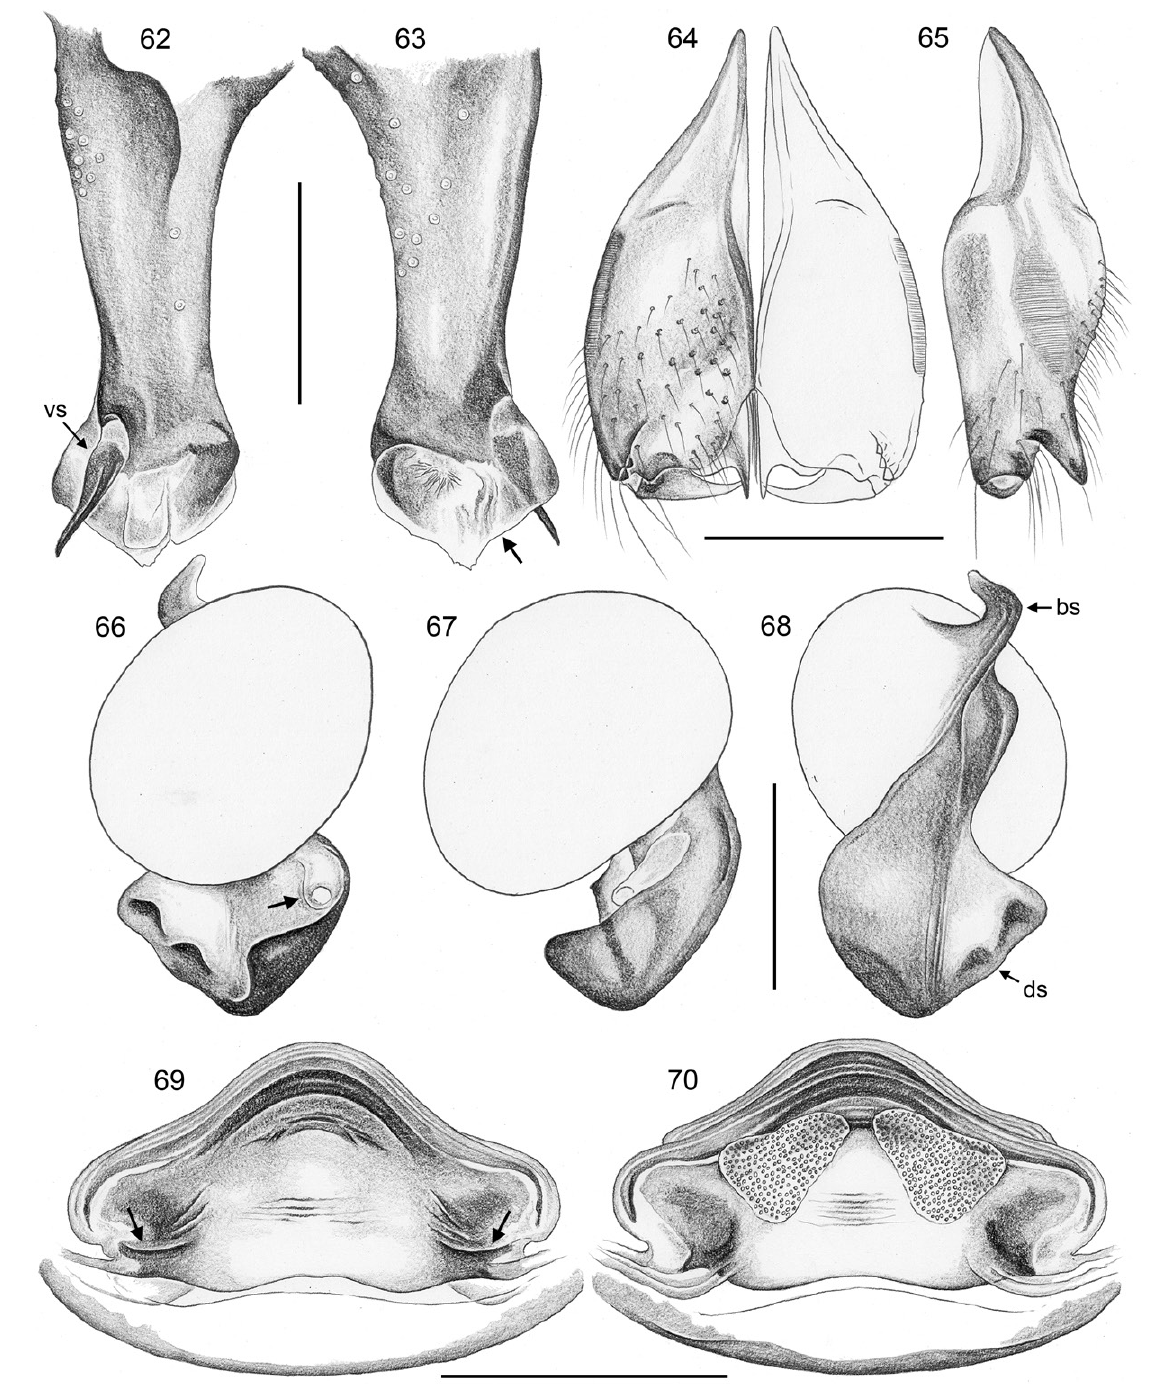
Figs 62–70. Holocnemus reini (C. Koch, 1873) comb. nov.; male from Morocco, near Tilamizene (ZFMK Ar 22319), female from Morocco, Al Kamoun (CAS 9027140). 62–63 . Left procursus, prolateral and retrolateral views; arrow: retrolateral membrane. 64–65 . Male chelicerae, frontal and lateral views. 66–68 . Left genital bulb, prolateral, dorsal, and retrolateral views; arrow: sperm duct opening. 69–70 . Cleared female genitalia, ventral and dorsal views; arrows: pockets. Abbreviations: bs = basal sclerite; ds = distal sclerite; vs = ventral sclerite. Scale bars: 62–63, 66–68 = 0.3 mm; 64–65, 69–70 = 0.5